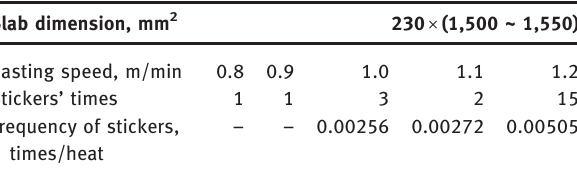
Table 1: Number of stickers under different casting speeds. Slab dimension, mm 